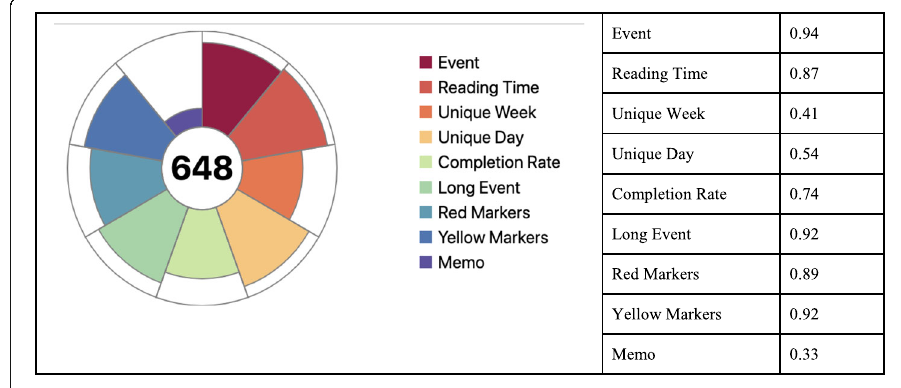
Fig. 7 Engagement score of effortful